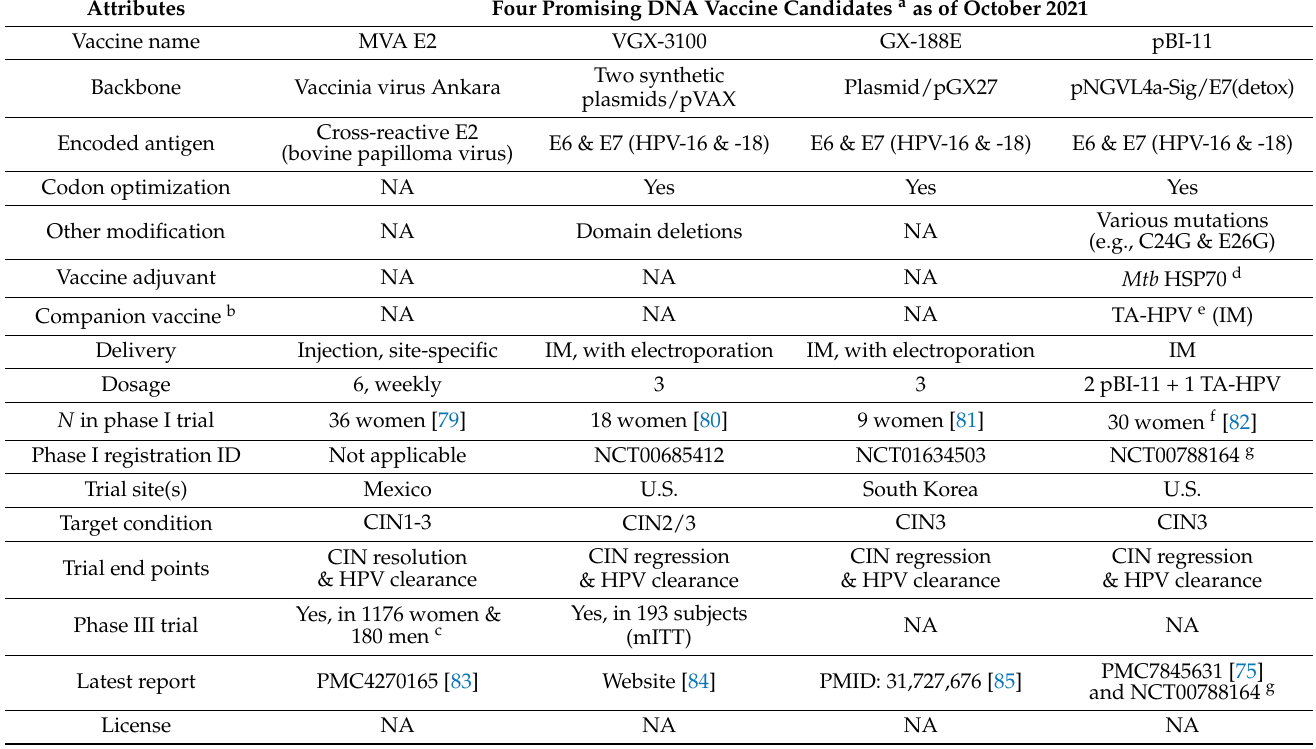
Table 2. Attributes of four therapeutic DNA vaccine candidates that have shown promising results against multiple HPV serotypes during or beyond phase I clinical